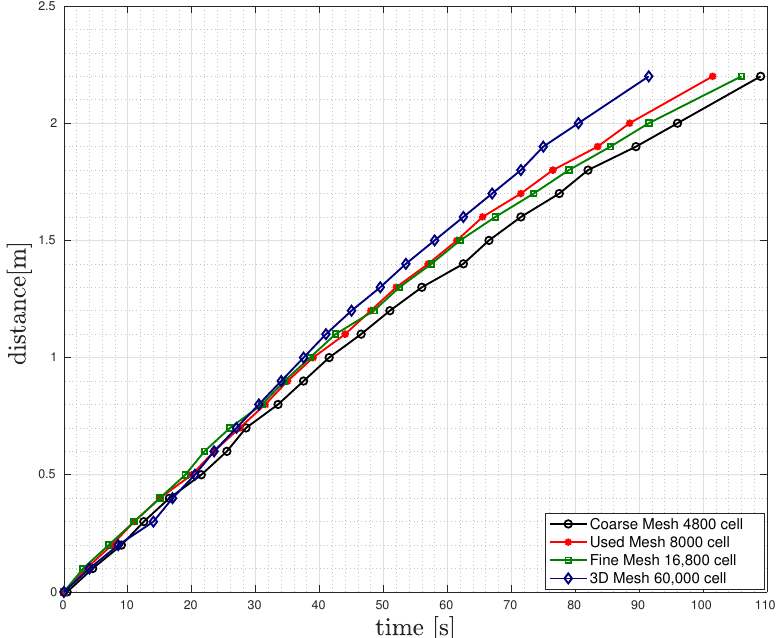
Figure 11. Grid-dependency study of numerical Run7. The front position of the current is plotted with respect to time for three different 2D meshes and one 3D